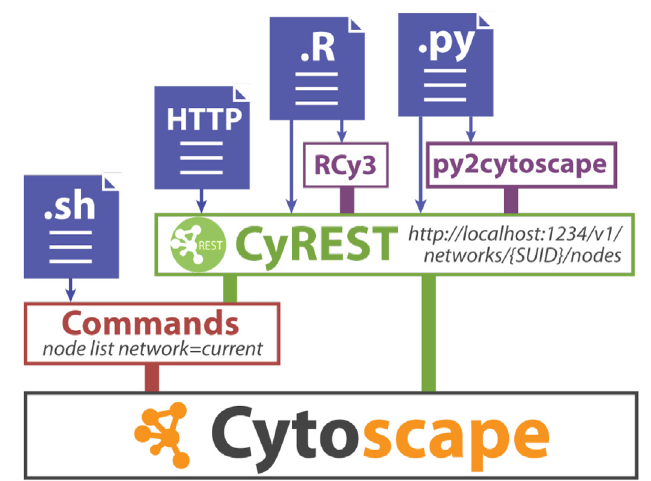
Figure 1. The Cytoscape Automation stack. The Java desktop version of Cytoscape (bottom) supports Commands (red) and CyREST (green) interfaces for scripting and automation either directly (blue) or via R and Python harmonization libraries